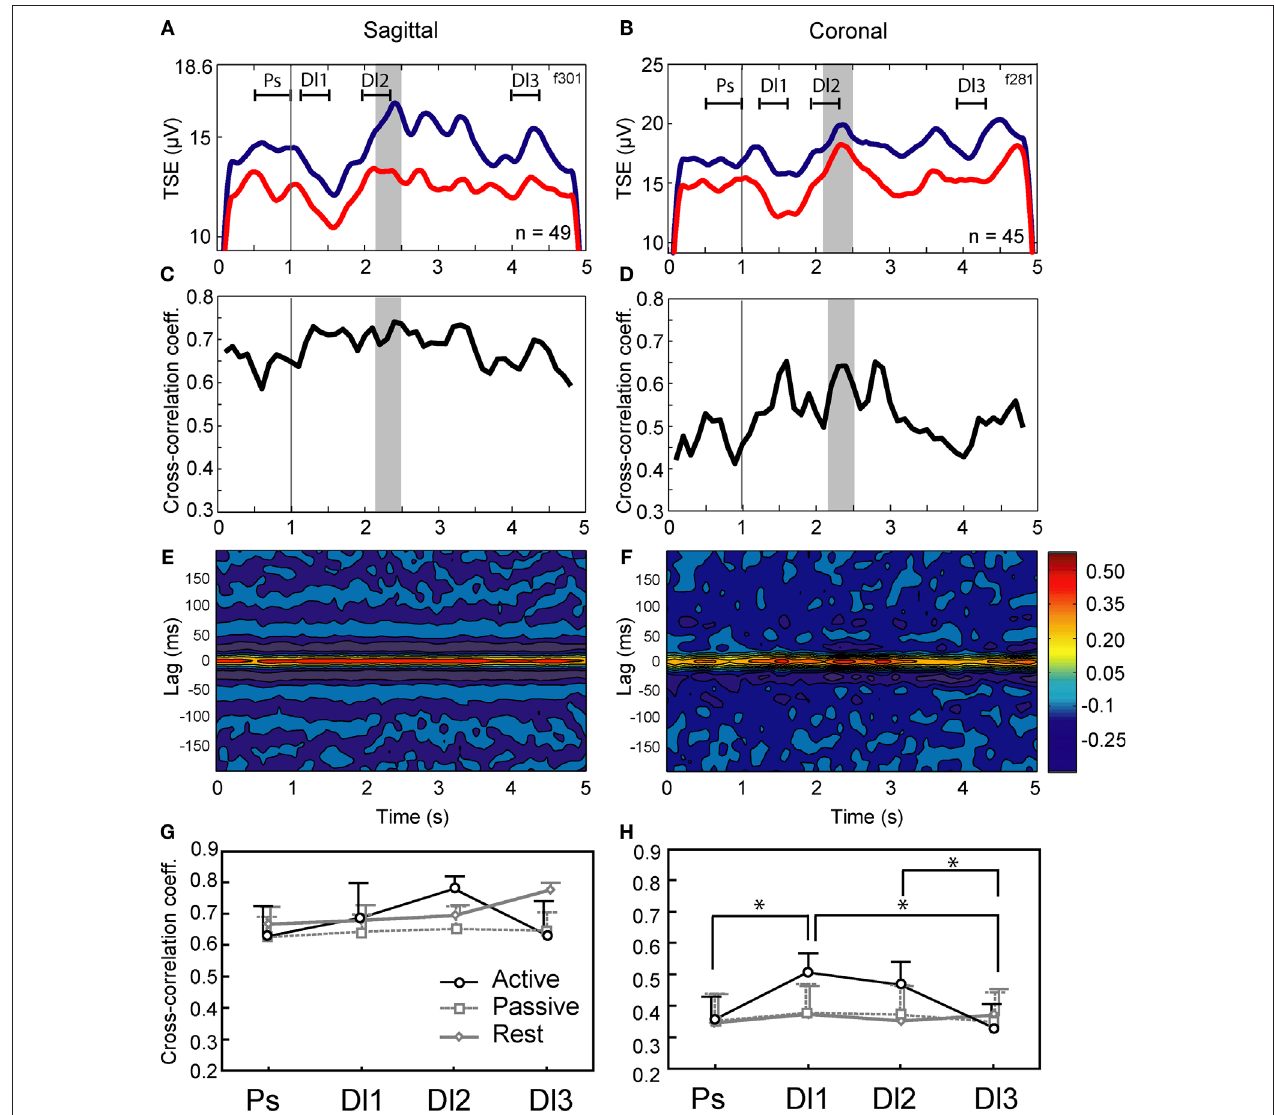
FIGURE 3 | Modulation of cerebellar LFP oscillations and synchronization of LFPs in the active condition, for a sagittal pair and a coronal pair. (A,B) Modulation of the 10–25 Hz oscillations across the trial, as shown by the temporal spectral evolution (TSE). Grey area: reward window, vertical line, stimulus onset. Line colors: A. blue-anterior, red-posterior; B. blue-medial, red-lateral. The different delays Ps, Dl1, Dl2, and Dl3 are indicated. (C,D) Cross-correlation coeffi cients for the same